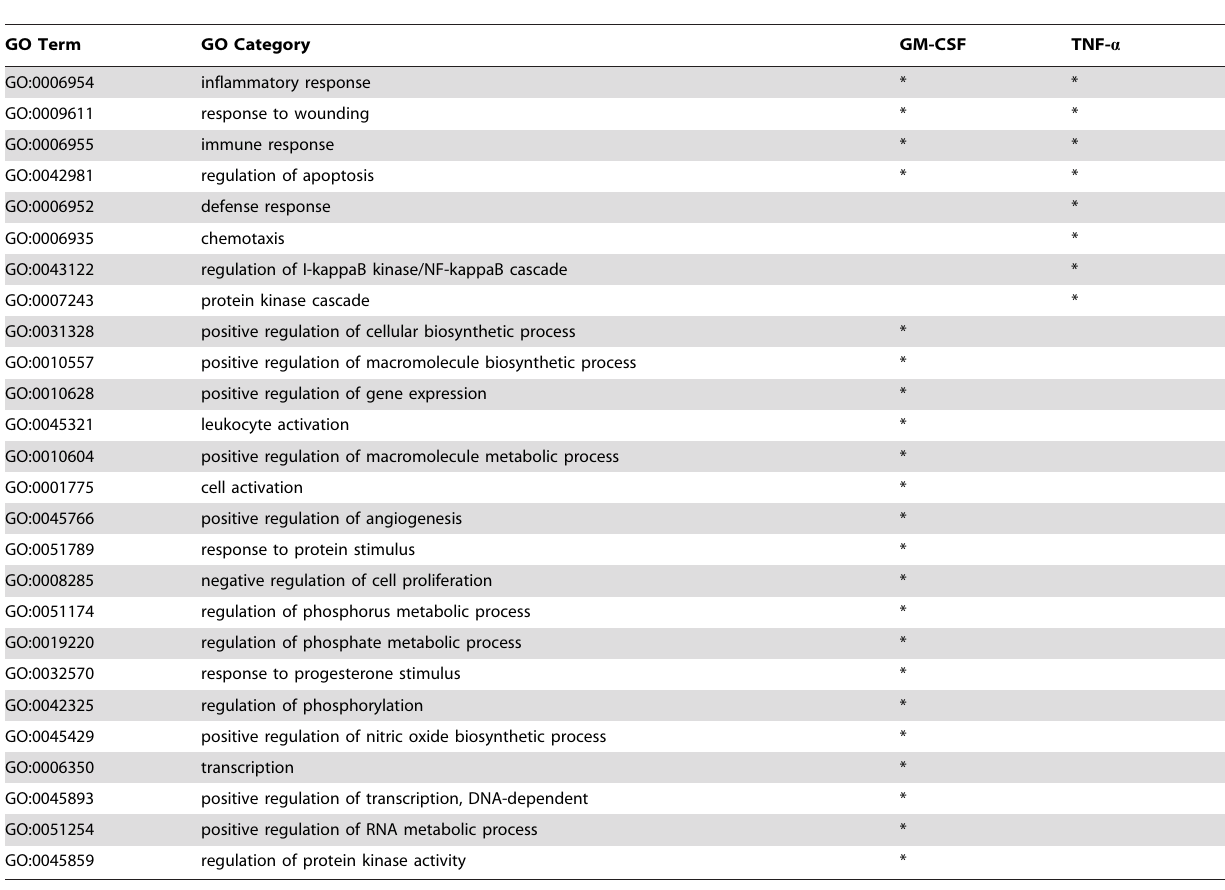
Table 2. Gene ontology analysis of genes with differential expression during priming by TNF- a or GM-CSF.